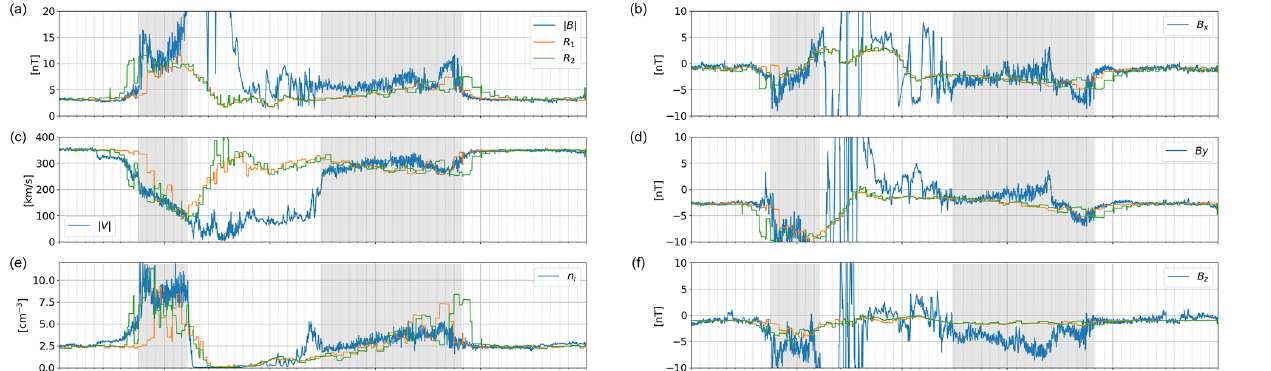
Figure 2. A comparison of MAVEN observations (blue) with two O + model runs ( R 1 in orange and R 2 in green) at 490s. Panels (a) , (c) , and (e) show the magnetic field magnitude, proton velocity, and proton number density, respectively. Panels (b) , (d) , and (f) show the three respective magnetic field components ( B x , B y , and B z ) in MSO coordinates. The location of the magnetosheath as seen from the observations is also indicated in gray. Thus, the induced magnetosphere is between the two gray regions.